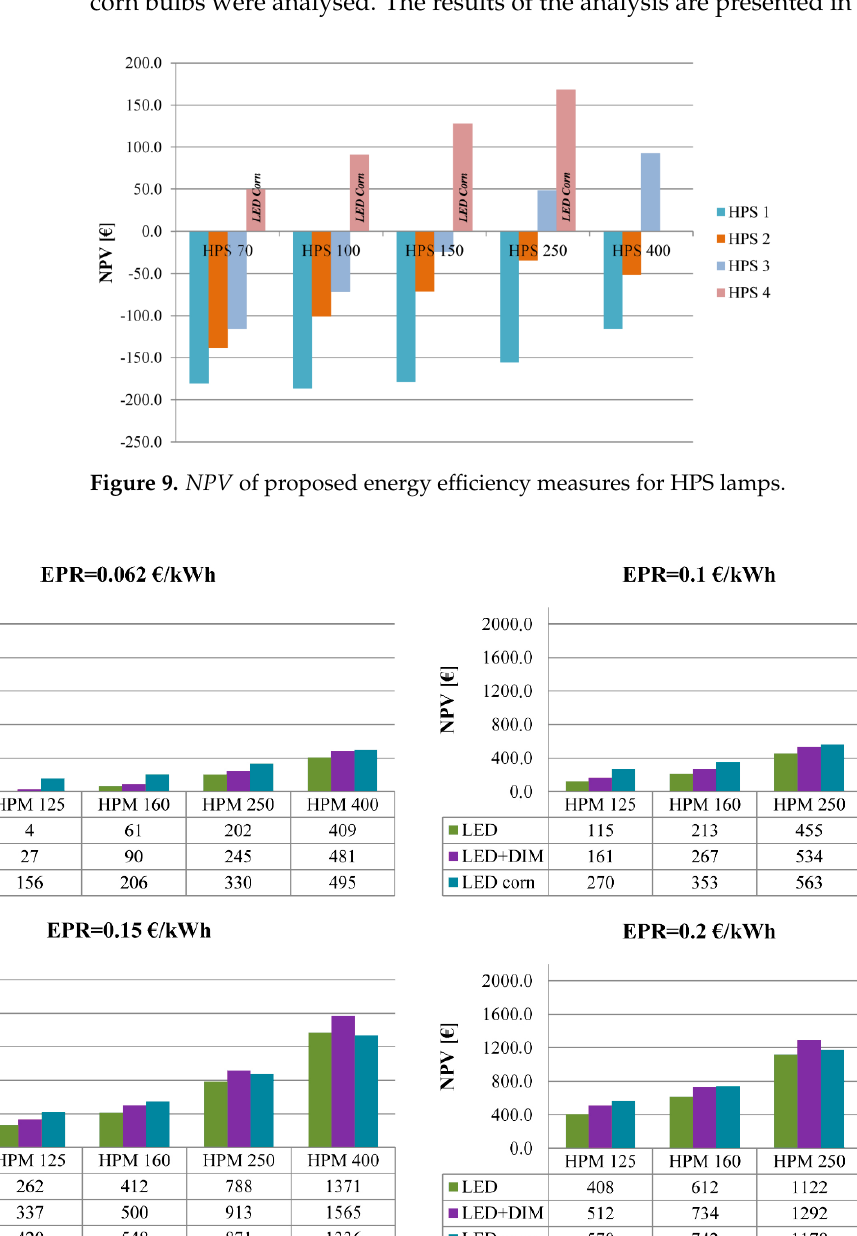
Figure 10. Influence of electricity price on NPV (energy efficiency measures for HPM lamps).